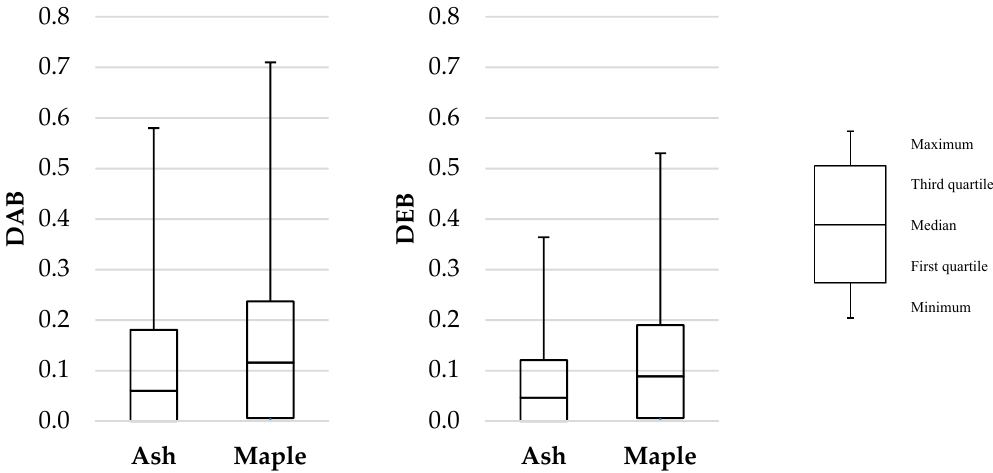
Figure 6. Boxplots separated after sorting criteria (maximum DEB and DAB in board) and species.